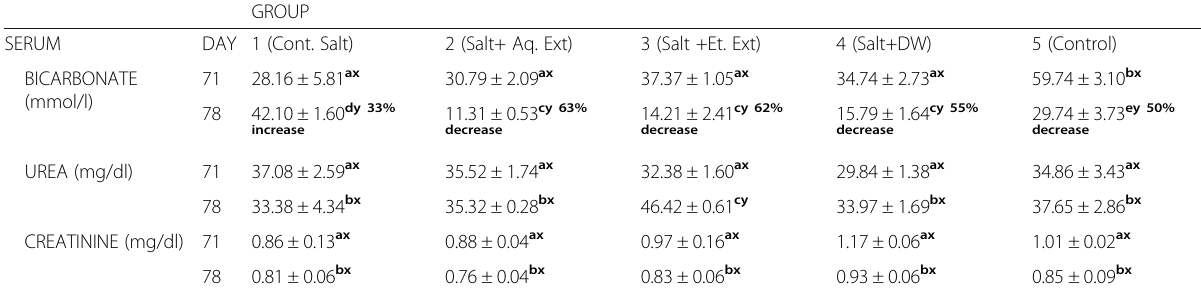
Table 2 The effects of oral administration of extracts (aqueous or ethanol) of A. wilkesiana leaves on serum bicarbonate, urea and creatinine concentrations of salt-loaded rabbits